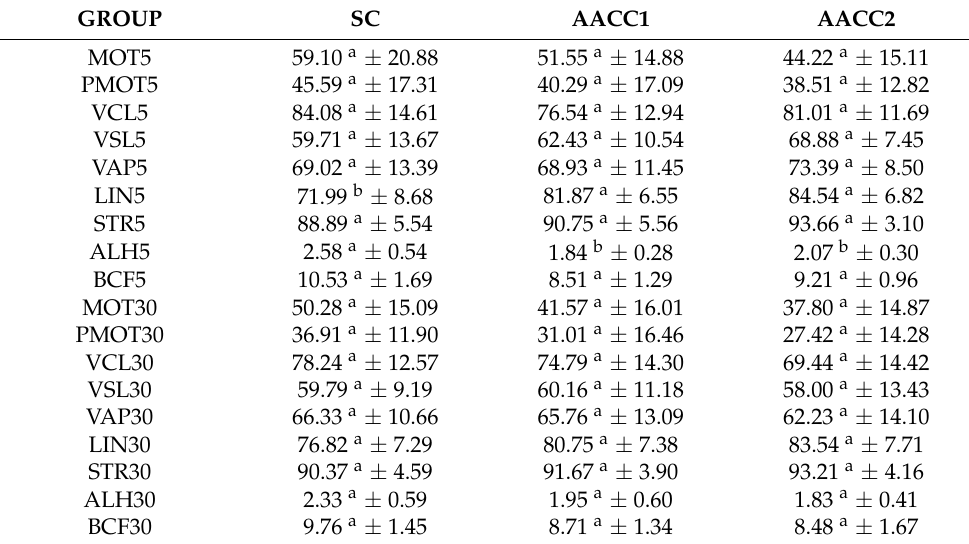
Table 2. Motility parameters values 5 and 30 min after